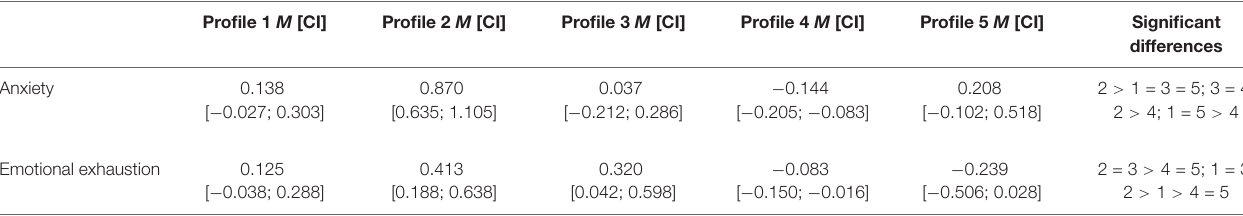
TABLE 5 | Associations between profile membership and the outcomes (bifactor